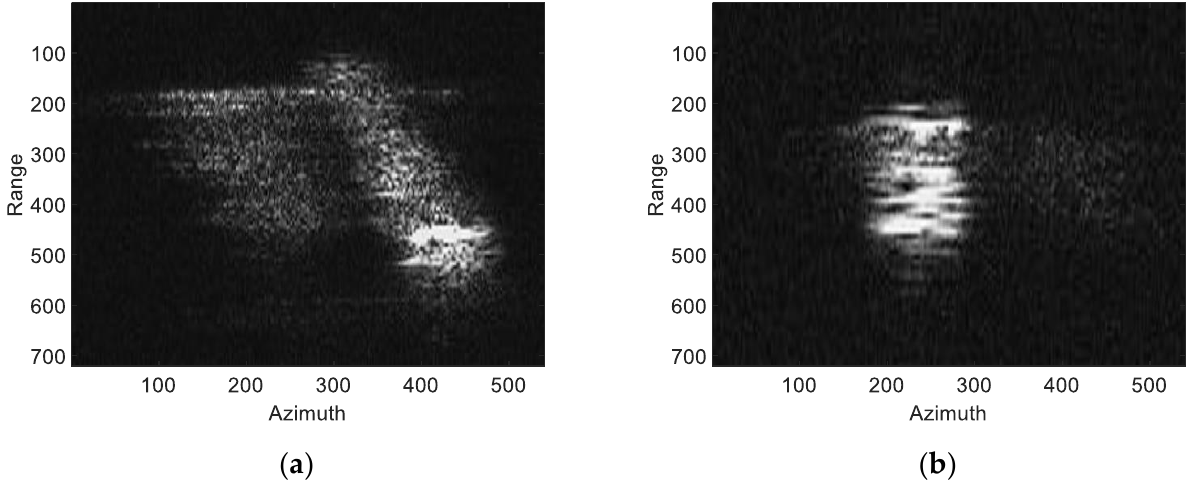
Figure 8. Imaging result of two ship targets from GF-3 measured data with traditional RDA. ( a ) Ship 1; ( b ) ship 2.